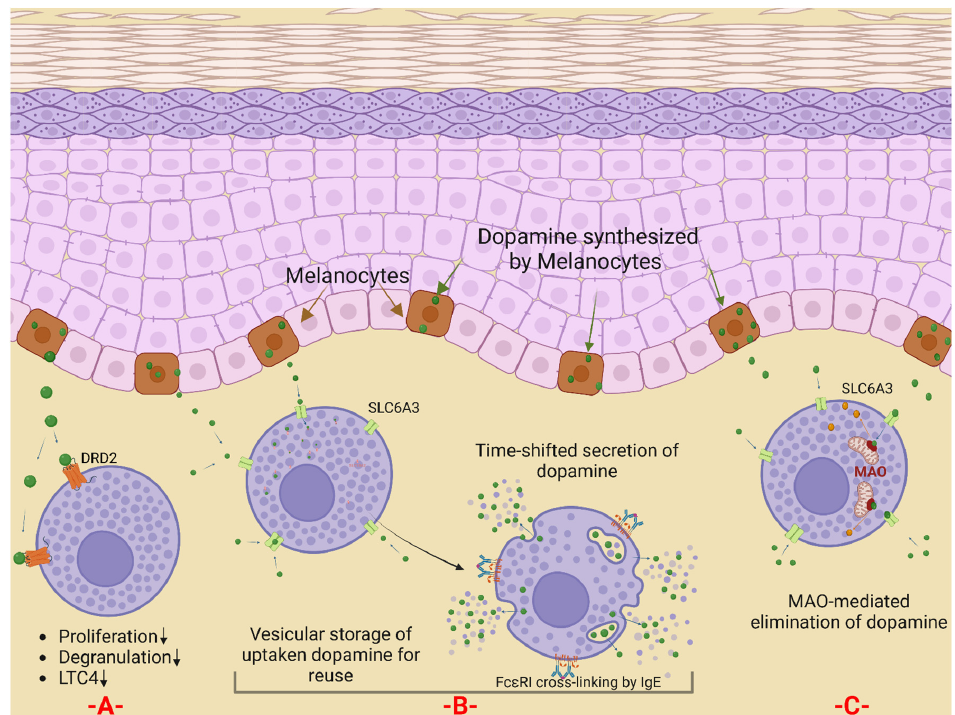
Figure 4. Hypothetical representation of the connections between dopamine and skin mast cells. Some skin cells, including melanocytes, can produce dopamine under physiologic and/or pathological conditions. ( A ) By virtue of their DRD2 receptor, skin MCs can respond to dopamine, which, analogously to other MCs, may dampen their proliferation and function. ( B ) MCs can take up dopamine via SLC6A3. The exogenously provided dopamine can be transported to MC granules and be exocytosed upon appropriate stimulation later. ( C ) Upon dopamine uptake via SLC6A3, dopamine may be transported to mitochondria to be degraded by MAO-A and/or MAO-B. In this latter scenario, MCs would function as dopamine scavengers. Table 1. Expression of selected gene sets and their comparison between mast cells and myelocytes or basophils. The expression data were extracted from Motakis et al. (2014) [49] and presented as RLE-normalized counts. Here, gene expression of skin-derived MCs was studied in parallel with ~400 different cell types from different tissues, using CAGE-seq analysis. This study provided the most comprehensive overview of the human MC transcriptome ever reported. Fold changes of differentially expressed genes were taken from Babina et al. (2014) [76]. Hereby, the MC transcriptome was compared with different blood cell types from the FANTOM5 project combined (i.e., not only MCs versus a single cell type, but MCs versus an overall myelocytic signature). CMA1 and MRGPRX2 are not discussed herein but were added for comparison as MC-selective entities. RLE Counts: Relative Log Expression (RLE)-based normalized counts by the means of samples. Gene Names